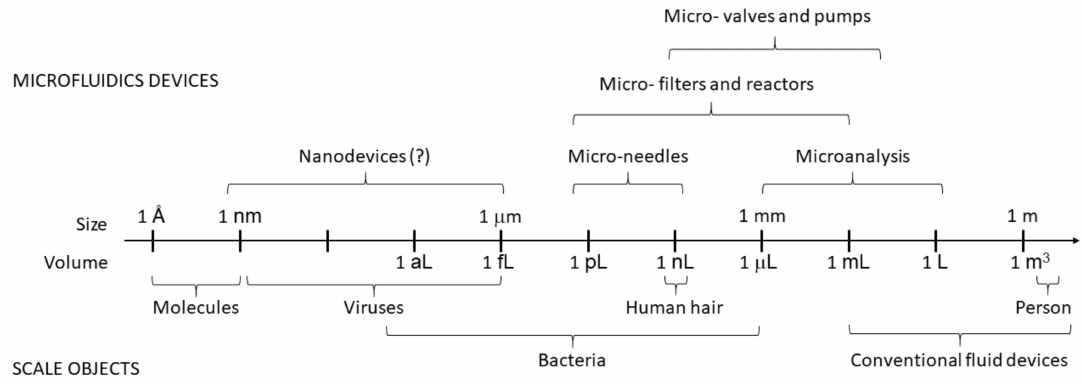
Figure 1. Scales and volumes in